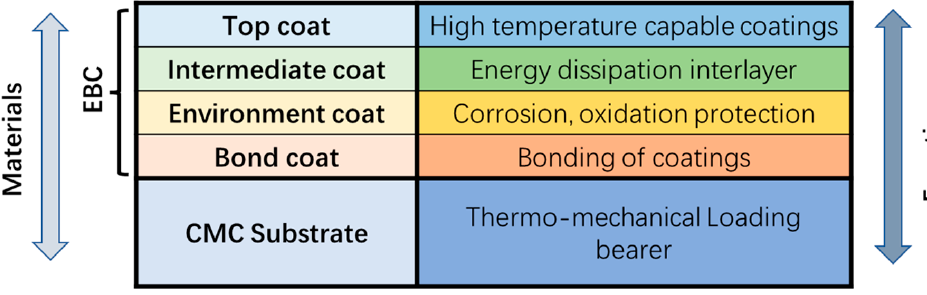
Figure 4. The materials and functions of a typical CMC/EBC system.